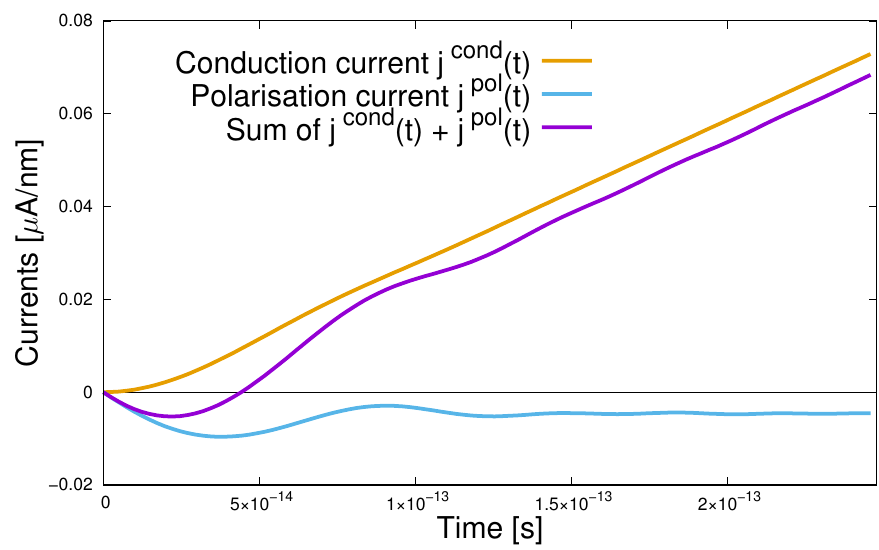
Figure 4. Conduction current (upper curve), polarization current (bottom curve) and their sum as a L /v F function of time for t (cid:28)